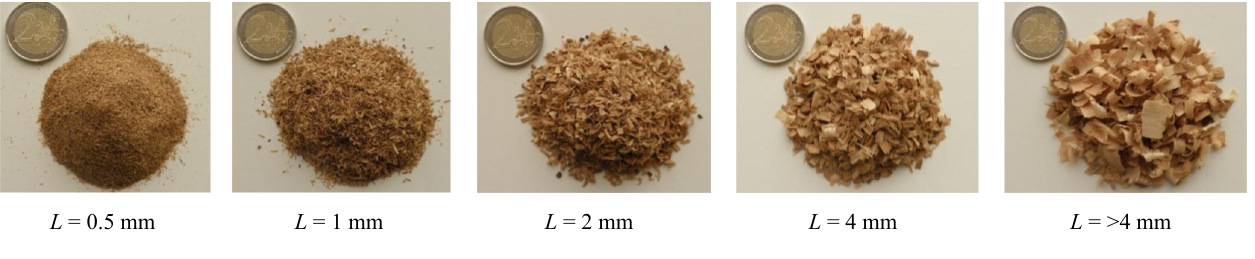
Figure 3. Beech sawdust particle